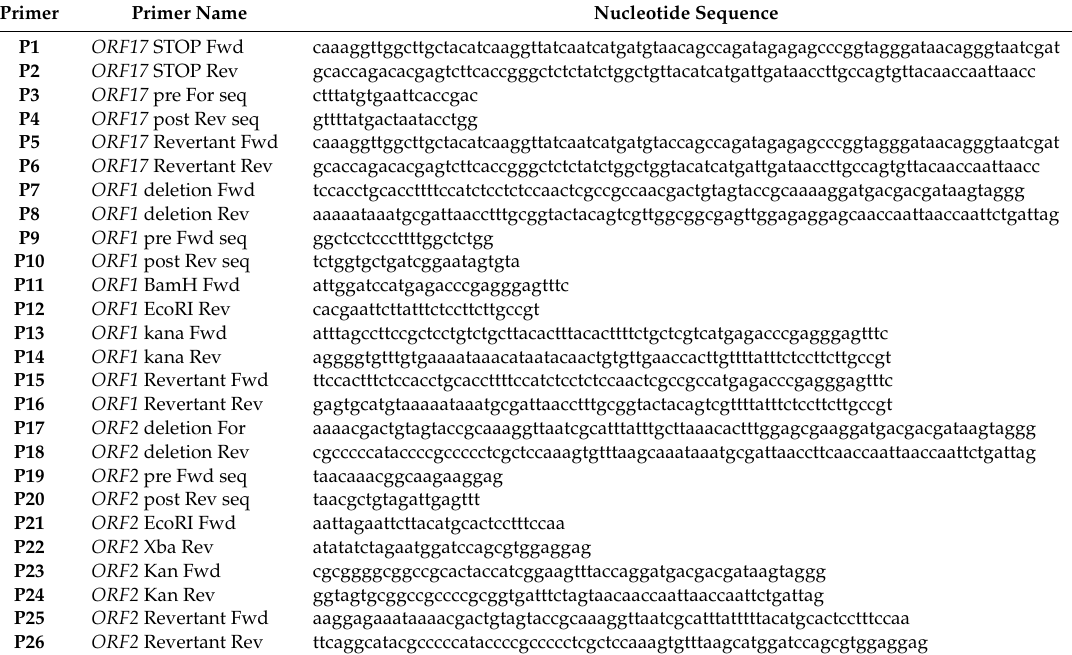
Table 1. List of primers used for construction of mutant and revertant equine herpesvirus type 1